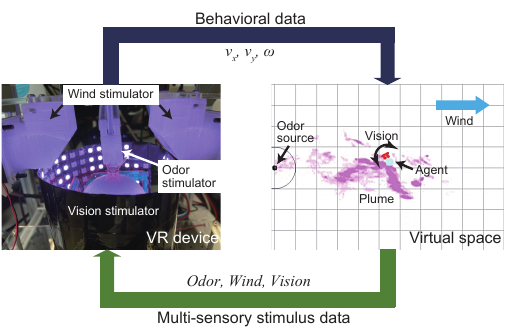
Figure 1. Schematic diagram of VR system for an insect. The VR device has an odor, wind, and visual stimulators. A VR device was connected to a virtual space on the computer, allowing the insect to perform odor-source localization virtually.